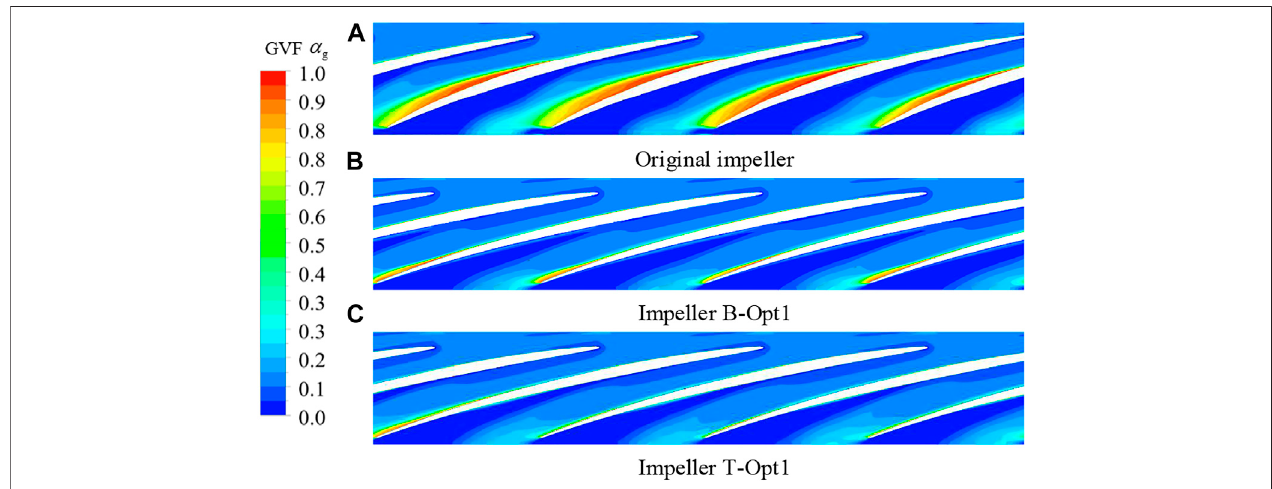
FIGURE 13 | GVF in impeller before and after optimization (span = 0.5). (A) Original impeller. (B) Impeller B-Opt1. (C) Impeller T-Opt1.